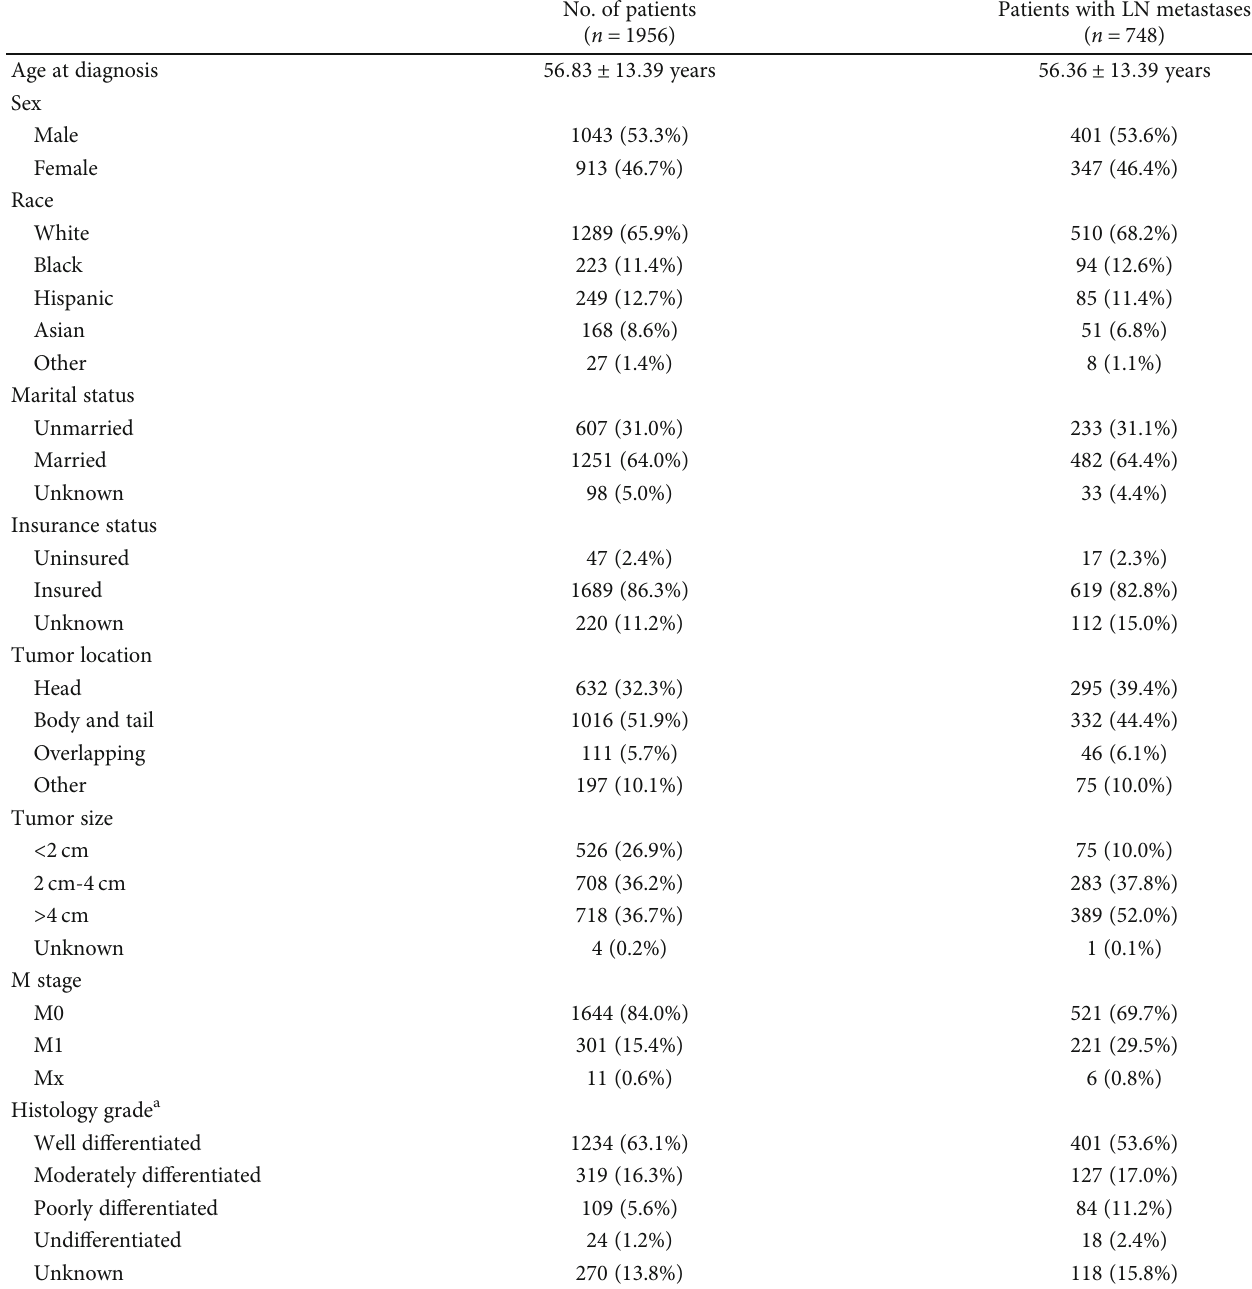
Table 1: Detailed demographic, clinical, and pathological features of the study